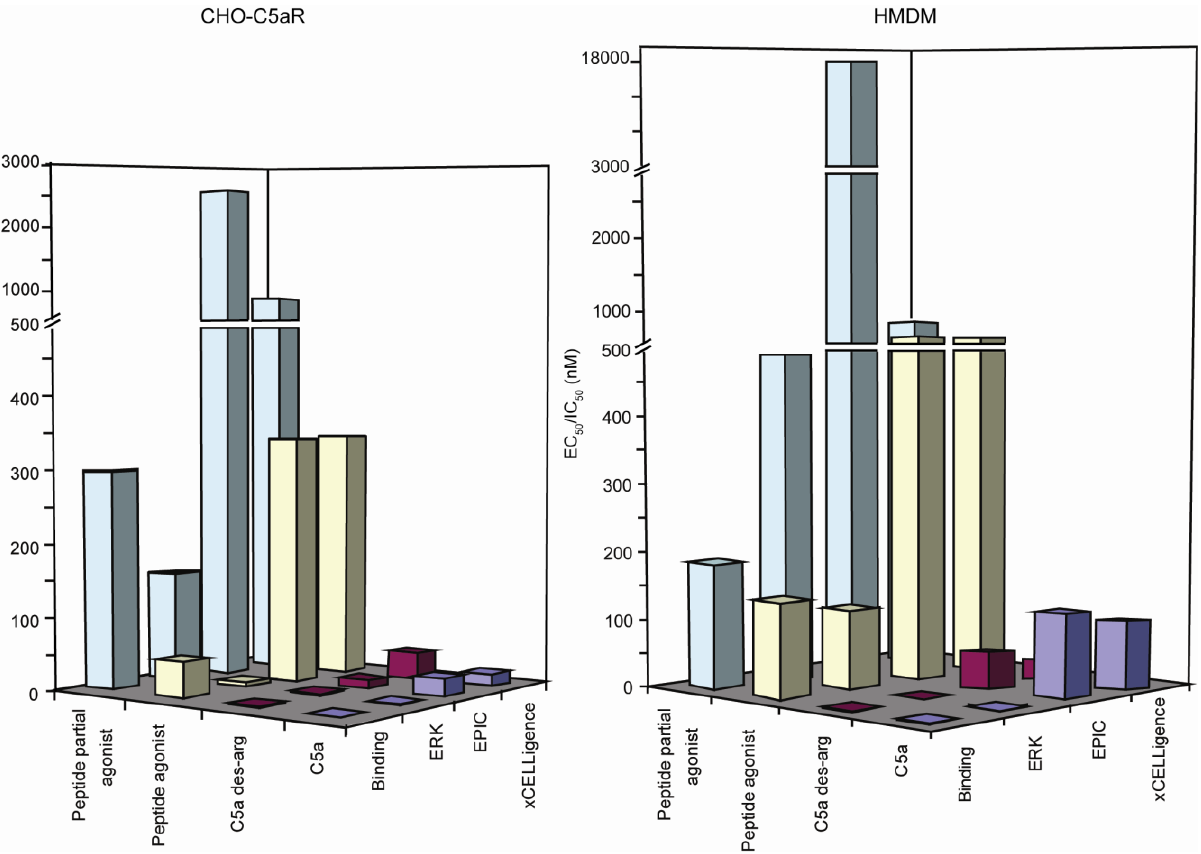
Figure 4. 3D bar graph comparison of data across all platforms for the different ligands